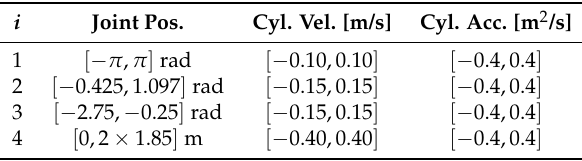
Table 3. Actuator/joint limits of the test-bed